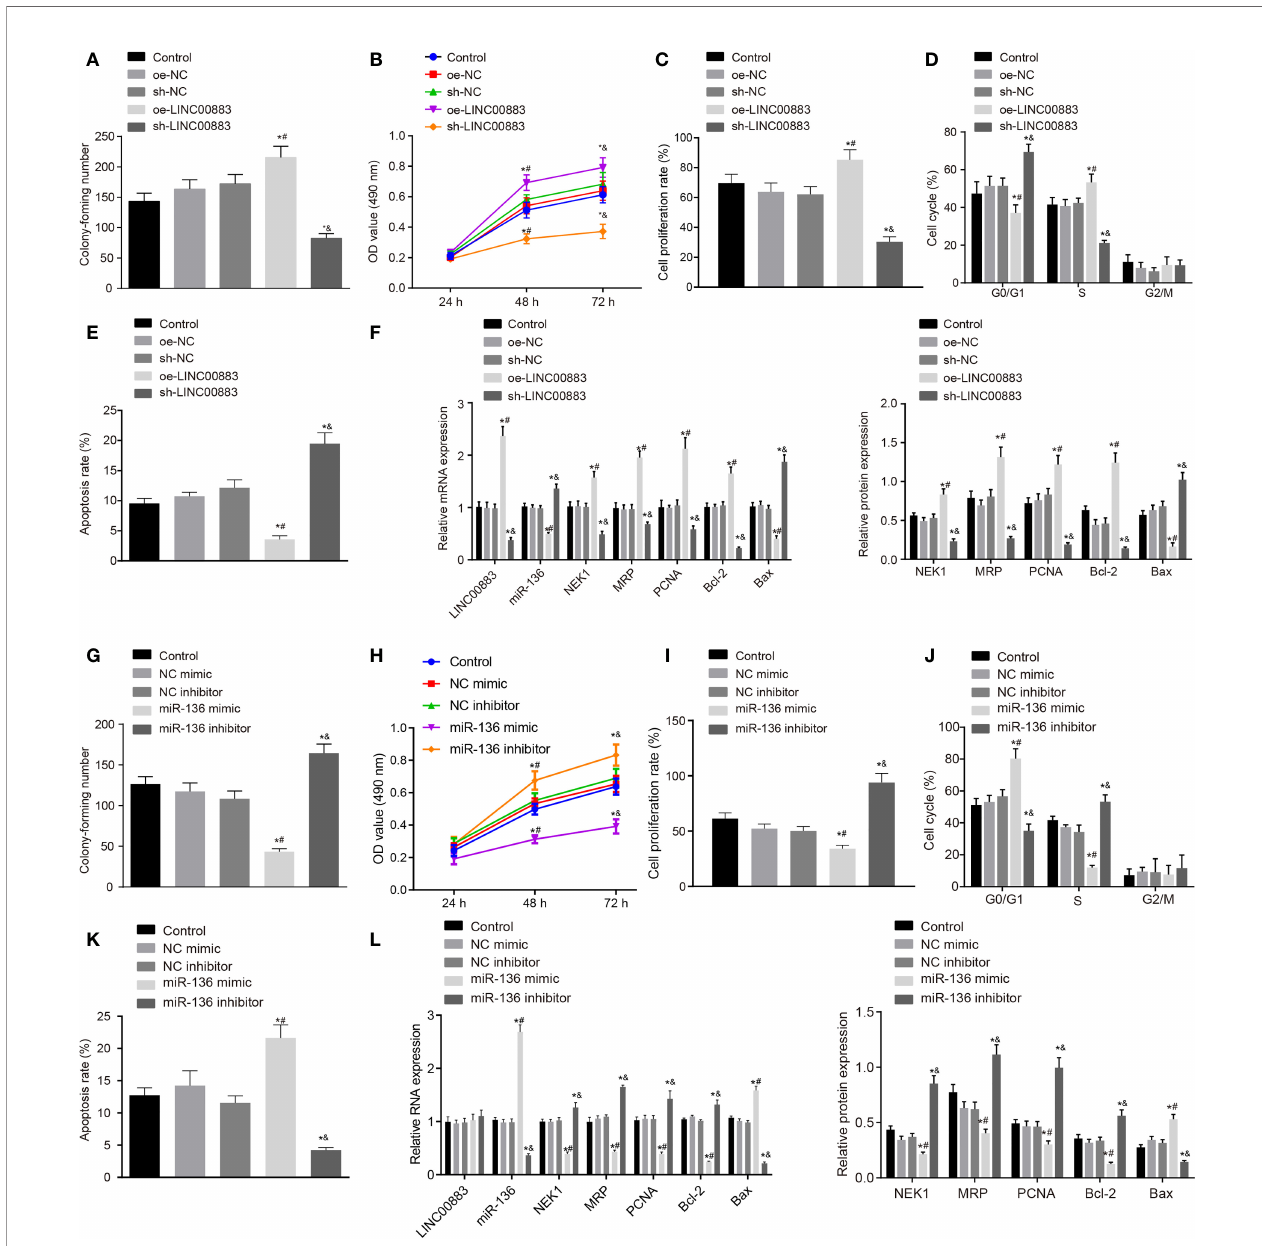
FIGURE 3 | Silencing of LINC00883 or overexpressed miR-136 inhibits colony formation and cell proliferation but enhances cell apoptosis in U251 cells. (A) The effect of ectopic expression and depletion of LINC00883 on colony formation of cells as examined by colony formation assay. (B) Viability of U251 cells when LINC00883 was upregulated or silenced as examined by 3-(4,5-dimethylthiazol-2-yl)-2,5-diphenyltetrazolium bromide (MTT) assay. (C) The effect of ectopic expression and depletion of LINC00883 on U251 cell proliferation as detected by 5-ethynyl-2 ′ -deoxyuridine (EdU) assay. (D) The effect of ectopic expression and depletion of LINC00883 on U251 cell cycle distribution as detected by fl ow cytometry. (E) The effect of ectopic expression and depletion of LINC00883 on U251 cell apoptosis as detected by fl ow cytometry. (F) The expression of LINC00883, miR-136, Bax, NIMA-related kinase 1 (NEK1), proliferating cell nuclear antigen (PCNA), multidrug resistance-associated protein (MRP), and Bcl-2 in U251 cells in response to ectopic expression and depletion of LINC00883 as examined by RT-qPCR and Western blot analysis. (G) The impact of ectopic expression and depletion of miR-136 on colony formation of cells by colony formation assay. (H) Viability of U251 cells after restoration or disruption of miR-136 as examined by MTT assay. (I) Cell proliferation mediated by ectopic expression or depletion of miR-136 in each group as assessed by EdU assay. (J) Cell cycle distribution in U251 cells after restoration or disruption of miR-136 as assessed by fl ow cytometry. (K) U251 cell apoptosis in response to ectopic expression or inhibition of miR-136 as assessed by fl ow cytometry. (L) The expression of LINC00883, miR-136, Bax, NEK1, PCNA, MRP, and Bcl-2 in cells in response to ectopic expression or depletion of miR-136 as measured by RT-qPCR and Western blot analysis. * p < 0.05 vs . the control group; # p < 0.05 vs . the oe-NC or NC mimic group; & p < 0.05 vs . the sh-NC or NC inhibitor group. The above data were expressed as mean ± standard deviation and analyzed by one-way analysis of variance. Biological and technical experimental replicates were performed in